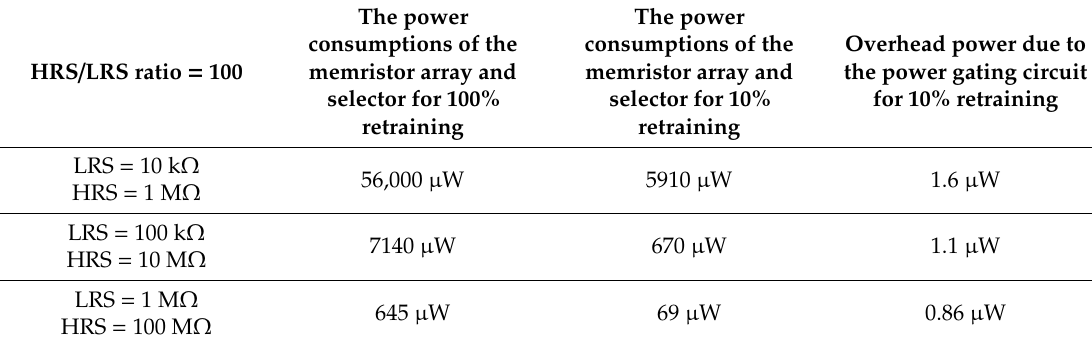
Table 1. Comparison of power consumption of 10% and 100% retraining for di ff erent LRS and HRS. In addition, the overhead power due to the partial gating circuit in Figure 3e is compared to the power consumption of the memristor array with selectors. The comparison in Table 1 indicates the overhead power is negligibly small than the array power